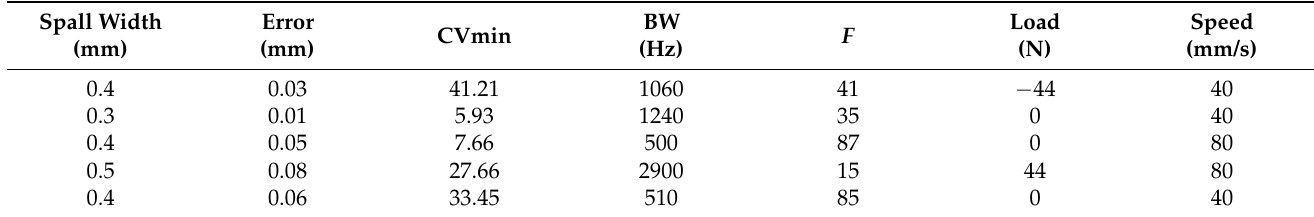
Table 4. Overall quantification